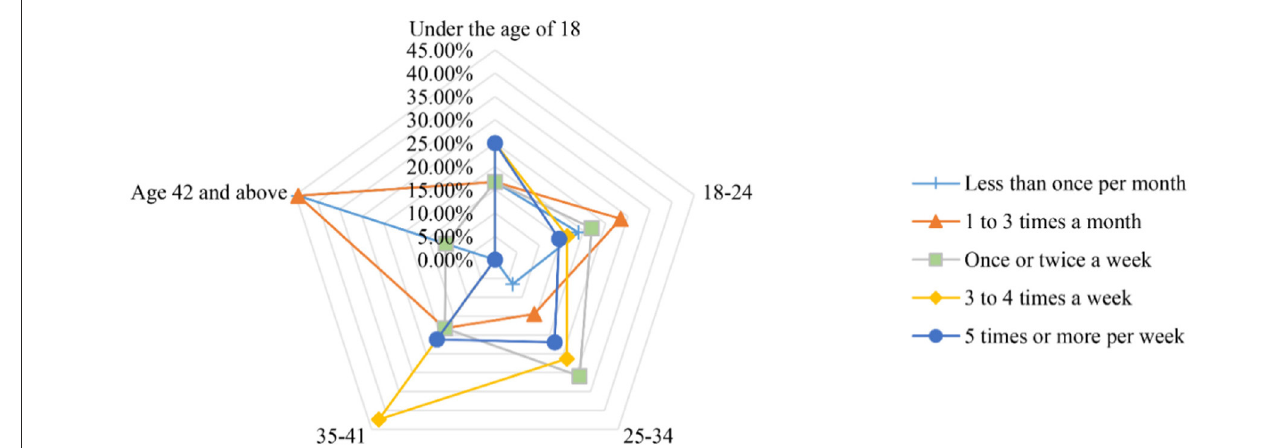
FIGURE7 Radar charts of the age group and frequency of use of ride-hailing services before the epidemic.